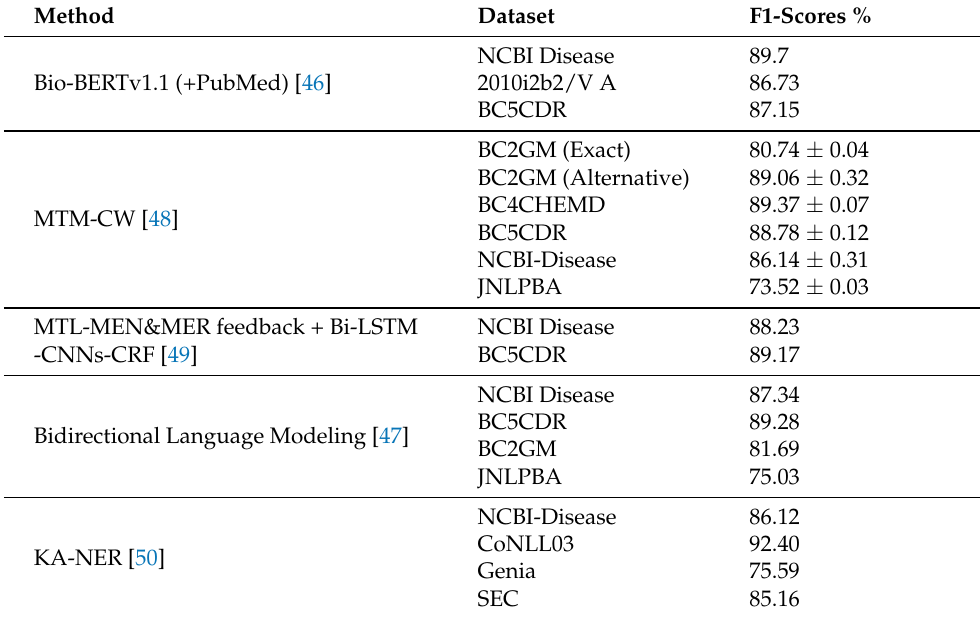
Table 3. F1-scores of each model on different